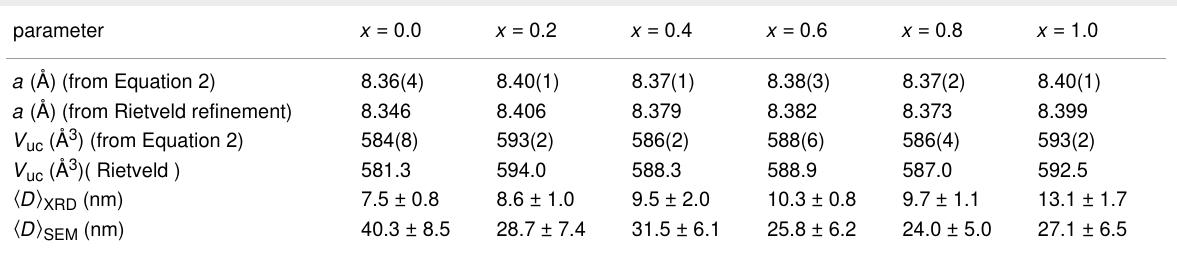
Table 1: Lattice constant ( a ), volume of unit cell ( V uc ), crystallite size ⟨ D ⟩ XRD and mean particle size ⟨ D ⟩ SEM . parameter